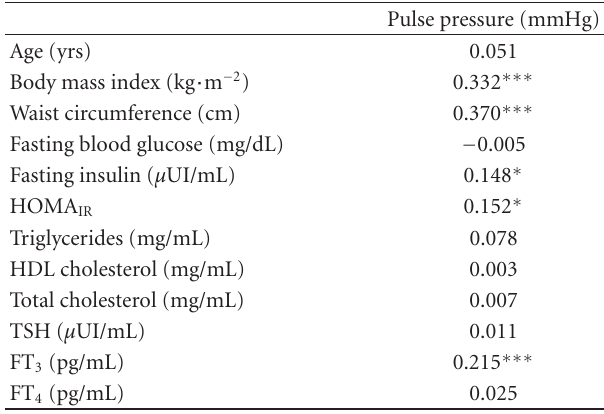
Table 5: Pearson correlation coe ffi cients of 24h mean pulse pres- sure (PP) with general, anthropometric, metabolic, and hormone variables in overweight and obese subjects under study ( n = 231).